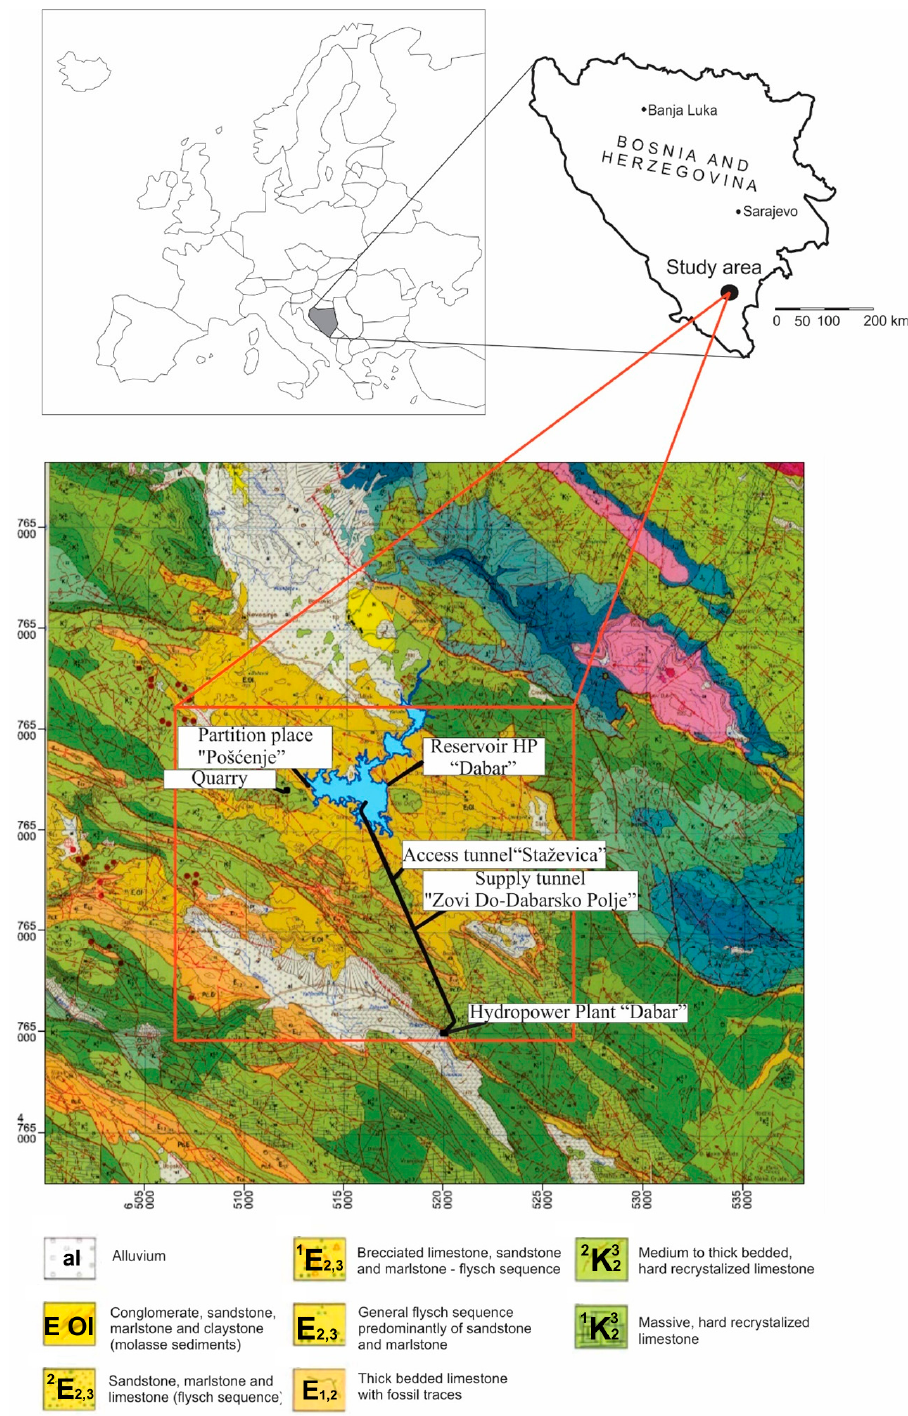
Figure 2. Geological map of terrain showing location of Dabar tunnel (not to